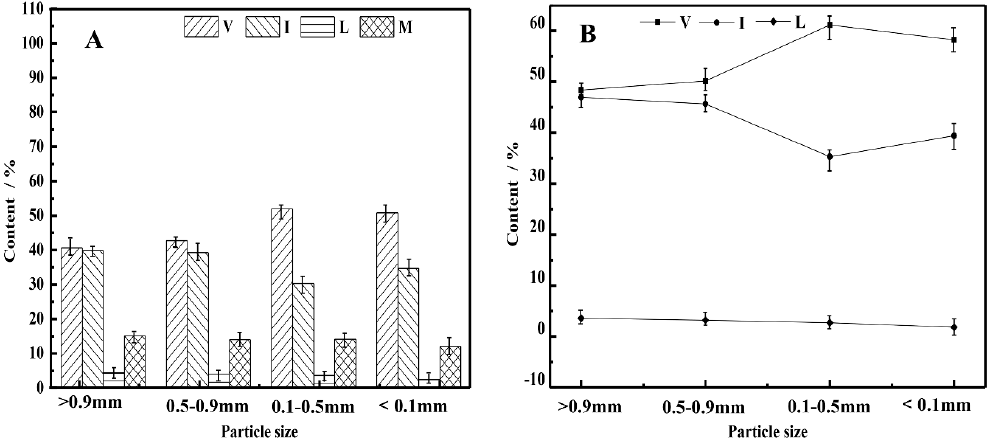
Figure 5. Particle sizes and the maceral content. ( A ) the macerals content of the mineral base, ( B ) the macerals content of the removed mineral base. V: vitrinite; I: inertinite; E: liptinite; M: minerals.